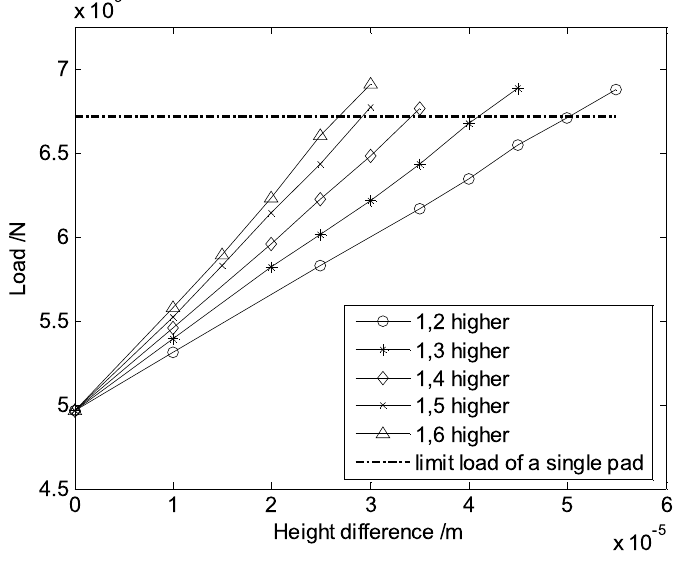
Fig. 12. Maximum load of all pads when two pads have larger